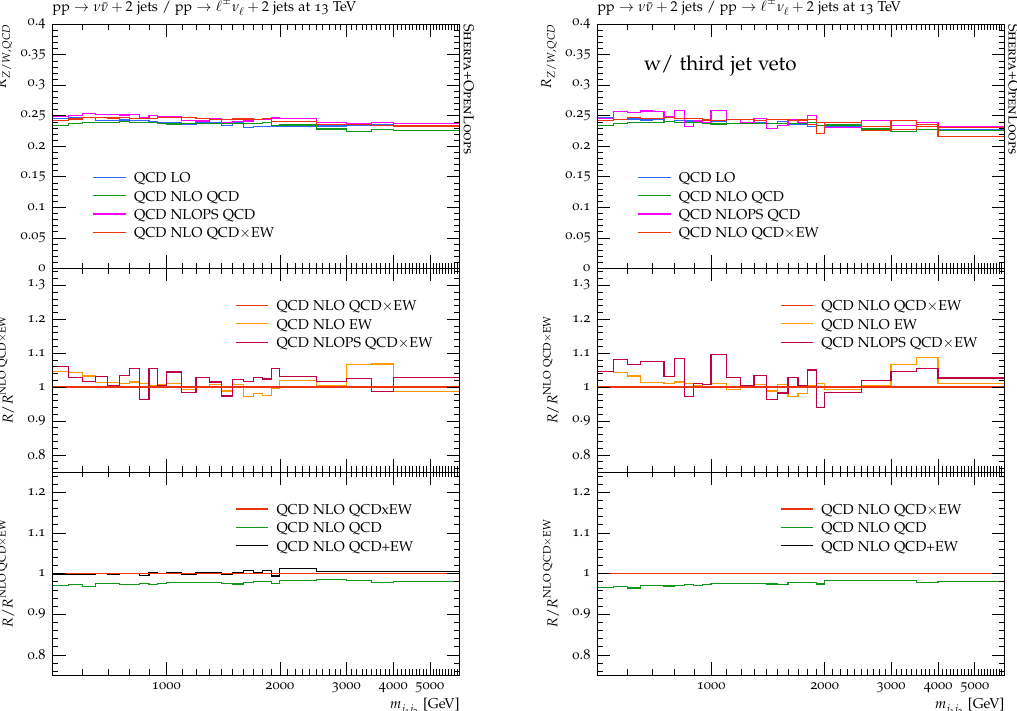
Figure 12. Ratios of the QCD pp → Z ( ν ‘ ¯ ν ‘ )+2 jets and QCD pp → W ± ( ‘ ± ν ‘ )+2 jets distributions in m j inclusive (left) and in the presence of the dynamic veto of eq. (3.12) against a third jet 1 j 2 (right). The upper panels compare absolute predictions at LO (blue), NLO QCD (green), NLOPS QCD (magenta) and NLO QCD × EW (red) accuracy. The impact of QCD corrections is illustrated in the middle panel, which shows the relative variation w.r.t. the nominal NLO QCD × EW prediction (red) when switching on the parton shower (NLOPS QCD × EW , purple) or switching off QCD corrections (NLO EW, orange). Similarly, the lowest panel shows the relative effect of switching off EW corrections (NLO QCD, green) or replacing the multiplicative by the additive combination of QCD and EW corrections (NLO QCD+EW,